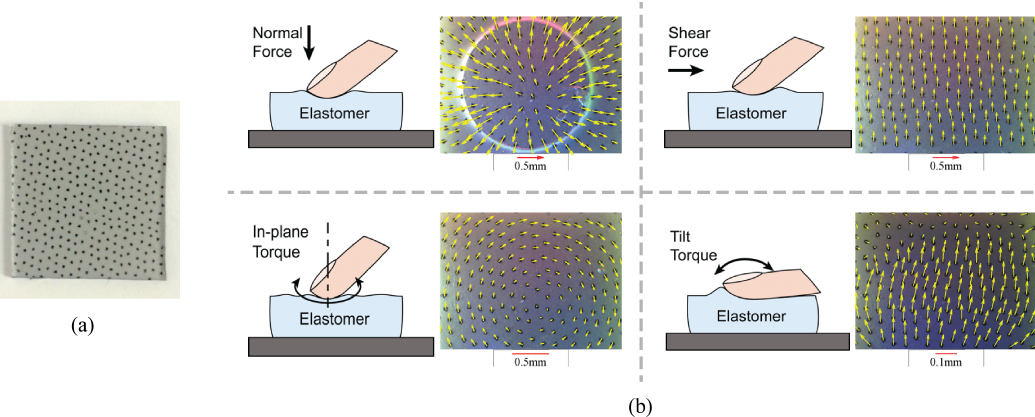
Figure 3. ( a ) an example pattern of printed markers on the GelSight. In the figure, the elastomer is for the fingertip GelSight sensor [30] (Got copyright permission from IEEE), with the dimension of 25 mm × 25 mm × 2 mm, the markers have an average interval of 1.1 mm; ( b ) the markers make diverse motion field patterns under different kinds of forces or torques. The magnitude of the markers’ motion is roughly proportional to the force/torque